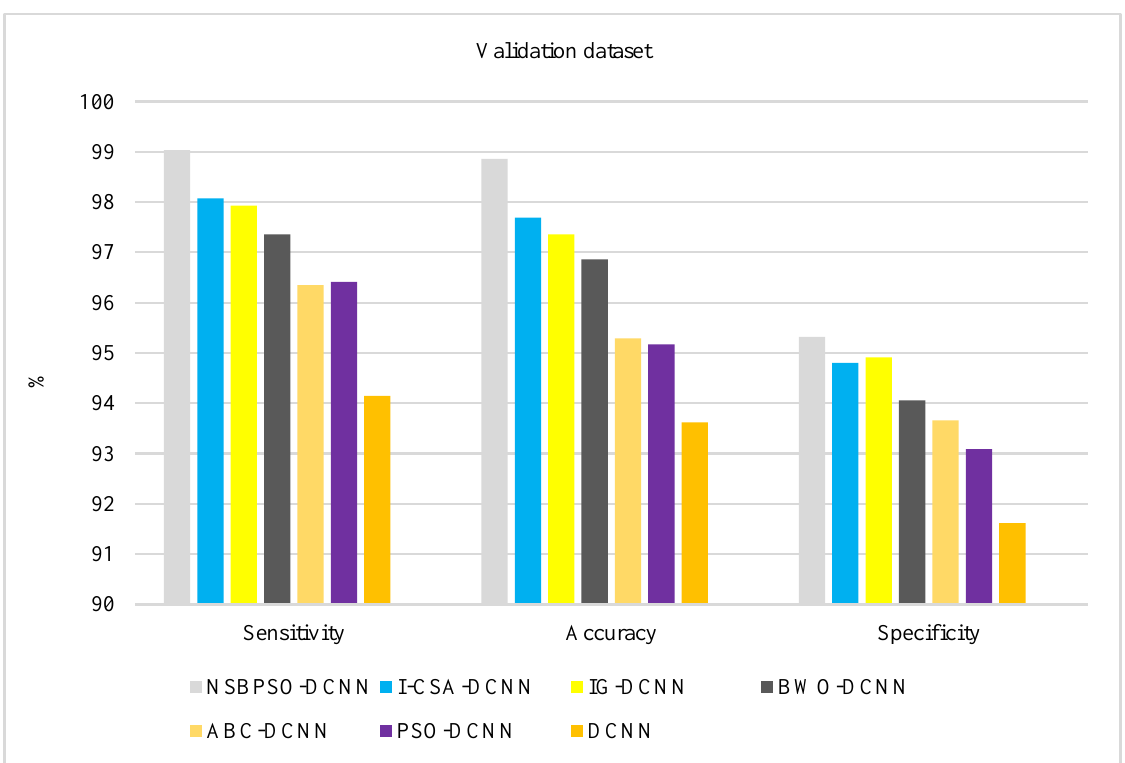
Figure 8. Comparison of the proposed architectures in the training dataset.